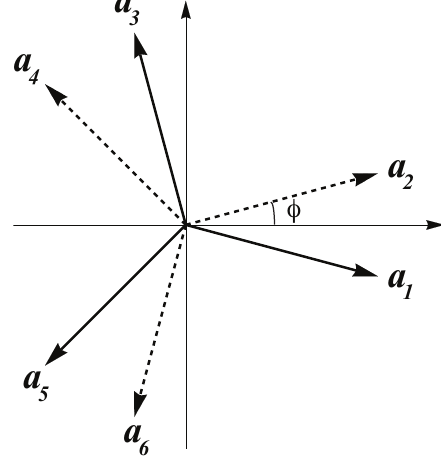
Figure 2. Plot of the star vectors in Equation